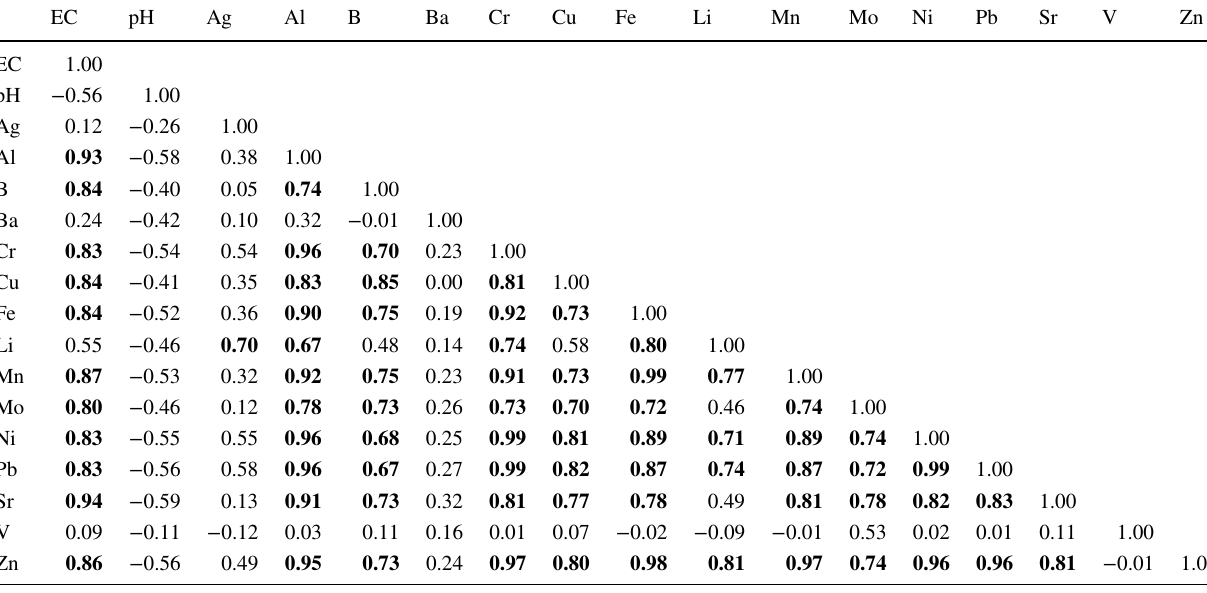
Fig. 3 Spatial distribution of contamination index in the Wadi Fatimah basin Table 5 Results of Pearson correlation